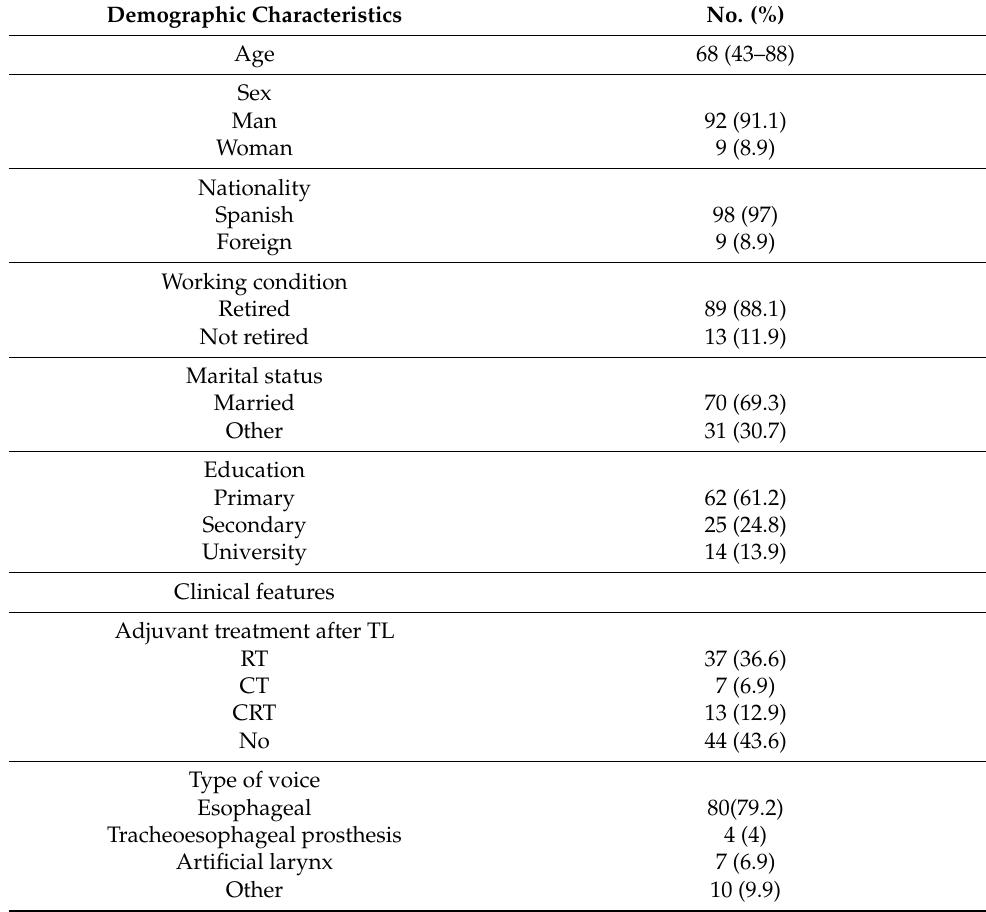
Table 1. Demographic characteristics and clinical